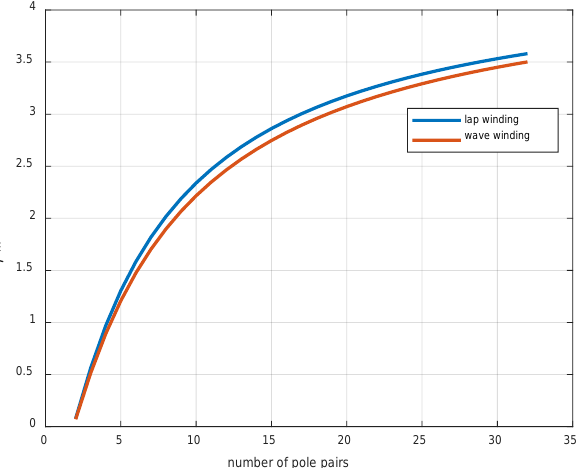
Figure 14. The torque-to-mass ratio as a function of the number of pole pairs for lap and wave wind- ings.